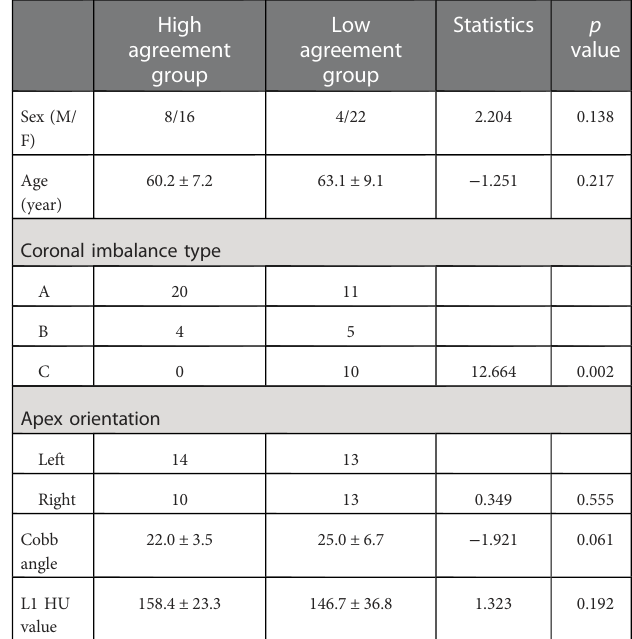
TABLE 2 Comparison of clinical and radiological data between high and low agreement